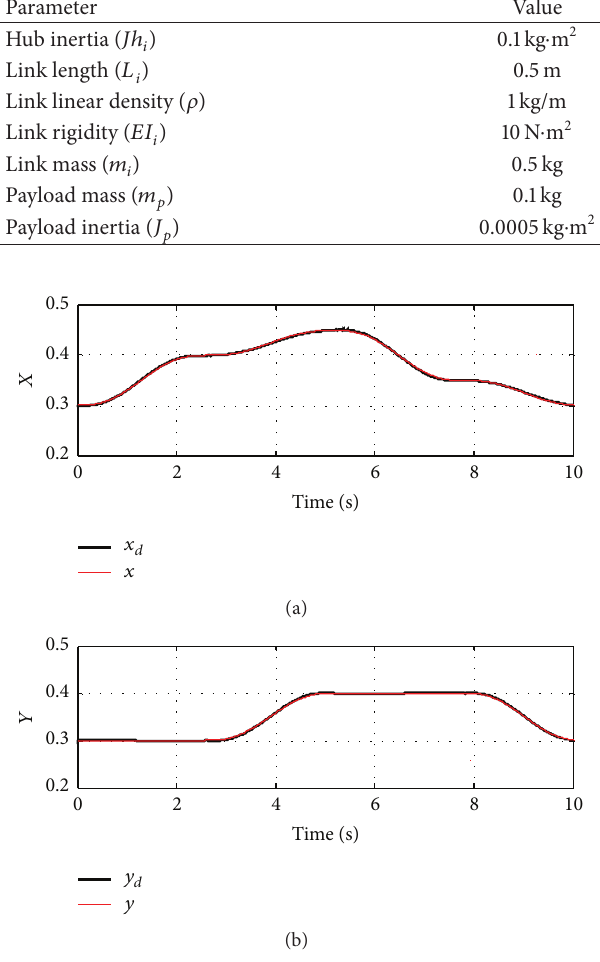
Figure 12: Tracking in the workspace. (a) 𝑥 -position tracking and (b) 𝑦 -position tracking.